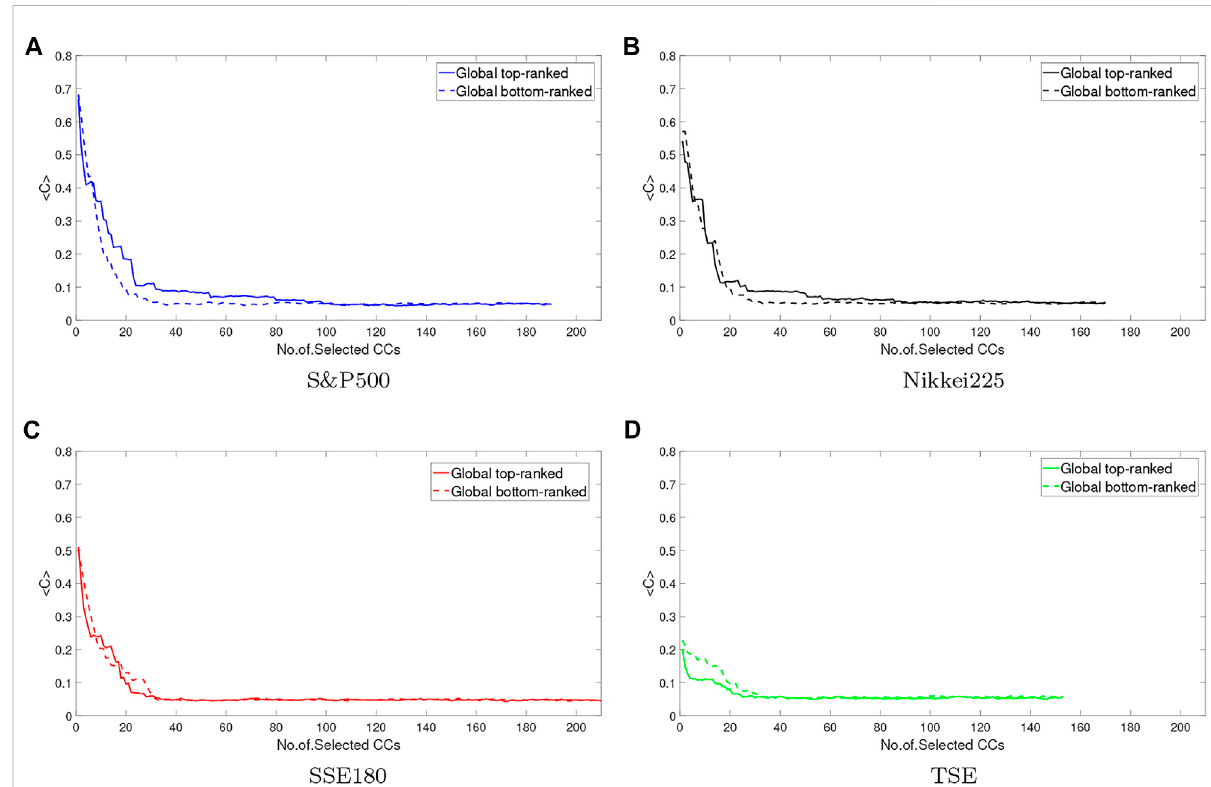
FIGURE 8 Comparing global perturbation by two methods top-ranked and bottom-ranked is plotted. As can be seen, the method of perturbation isn ’ t effective in results. (A) S&P500, (B) Nikkei225, (C) SSE180, (D)